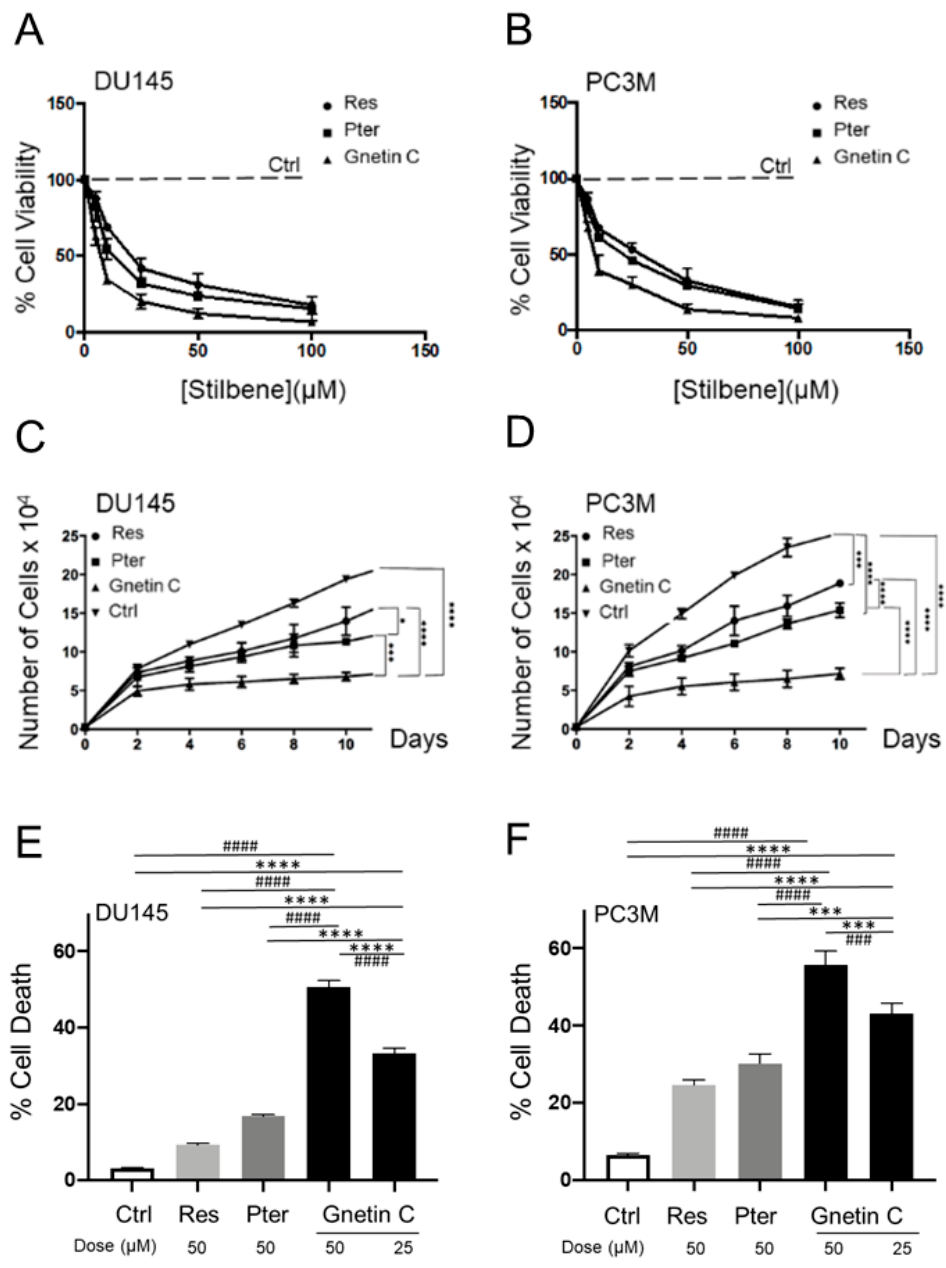
Figure 2. Gnetin C induces cytotoxicity in DU145 and PC3M prostate cancer cells more potently than Res and Pter. ( A , B ) A dose-dependent (5–100 µM) cell viability assay was performed after 72 h of treatment with compounds. Viable cells were plotted as percent of vehicle treated cells (Ctrl), which was set as 100%. ( C , D ) Effects of Gnetin C, Res and Pter on prostate cancer cell proliferation. Cells were plated in phenol-red-free media supplemented with 5% charcoal-stripped serum and cultured in the presence of 5 µM of compounds for 10 days. ( E , F ) Analysis after treatment with compounds was performed using Flow Cytometry and sub-G1 population was calculated. Data represent the mean ± SEM of three independent experiments. Data represent the mean ± SEM of three independent experiments, in which each data point was performed in triplicates. * p < 0.05; *** p < 0.001; **** p < 0.0001 (significance vs. Gnetin 25); ### p < 0.001; #### p < 0.0001 (significance vs. Gnetin 50) (two-way ANOVA).